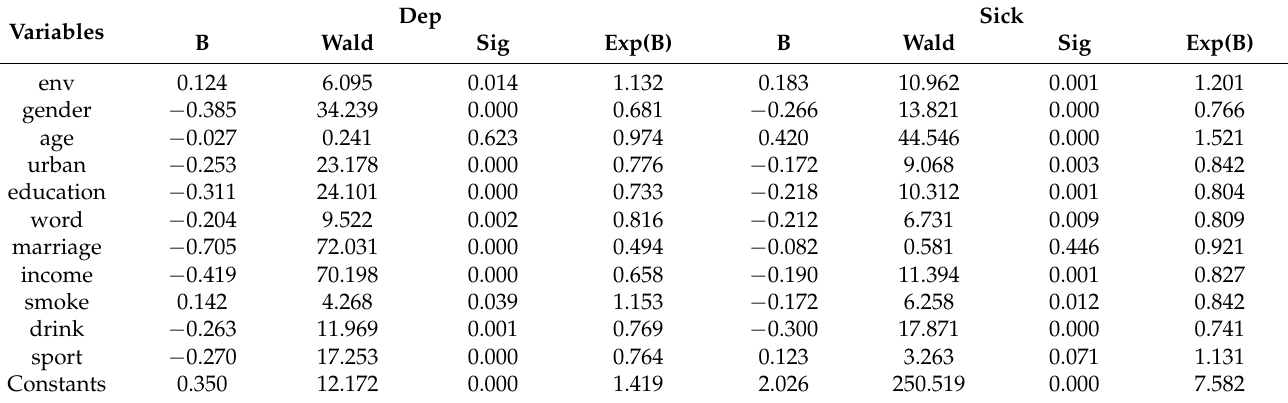
Table 5. Analysis of factors affecting the health of middle-aged and older